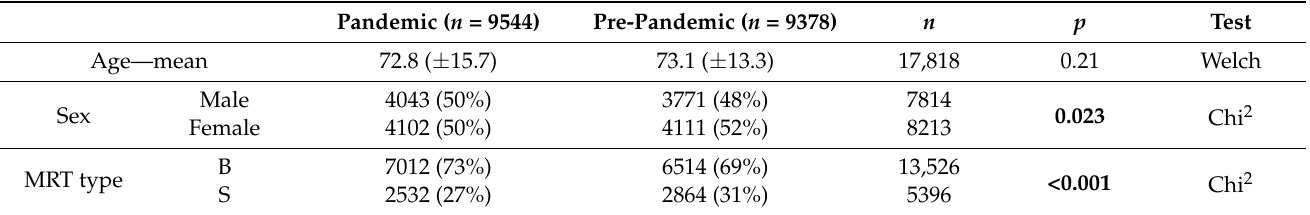
Table 1. Baseline